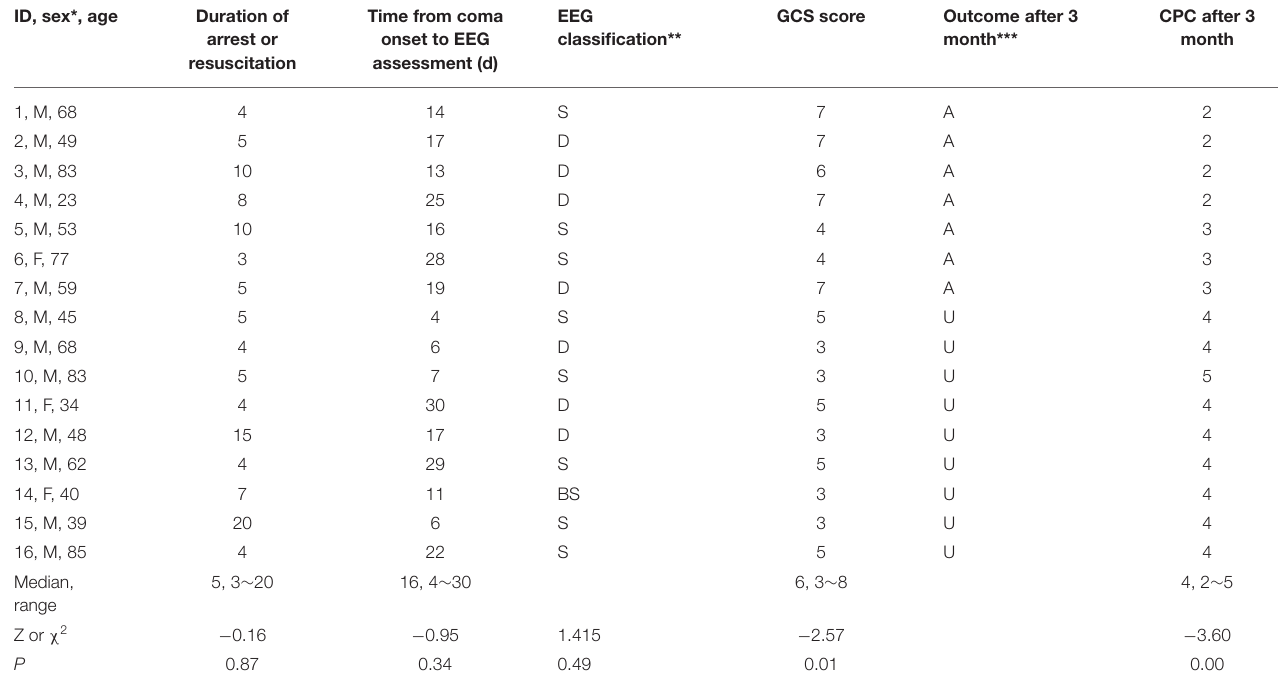
TABLE 2 | Baseline data of